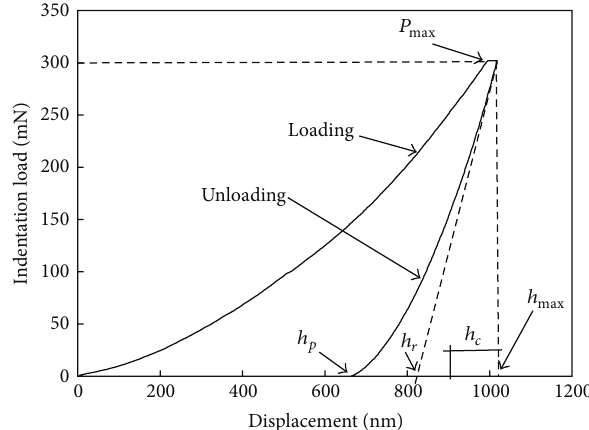
Figure 2: Schematic representation of a typical load versus indenter displacement data for an indentation